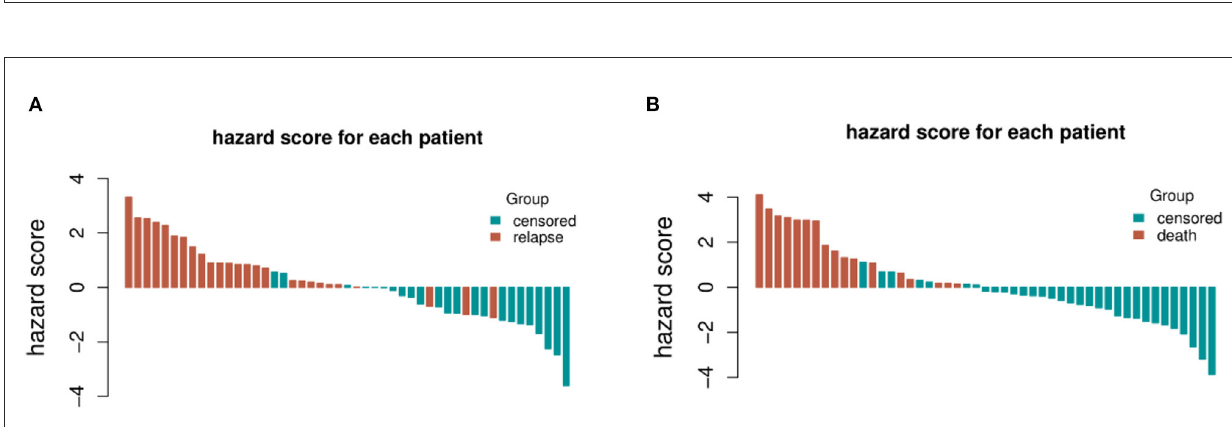
FIGURE4 The distribution of hazard score and survival status for each patient included in the validation set. (A) Recurrence and (B)